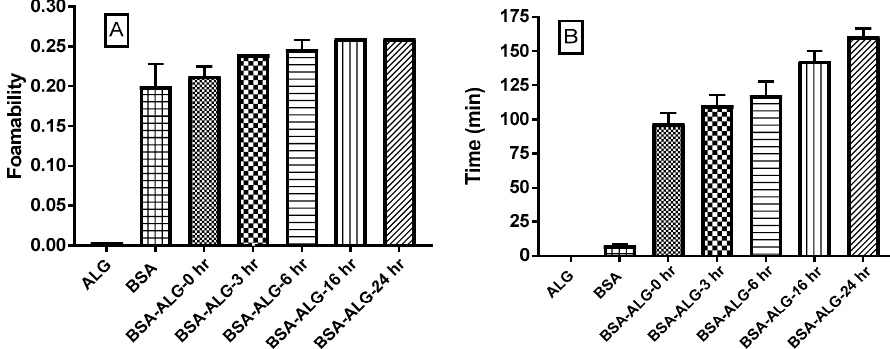
Figure 2. The foamability ( A ) and foam stability (min) ( B ) of ALG, BSA, and BSA-ALG conjugates (0, 3, 6, 16, and 24 h) solutions.